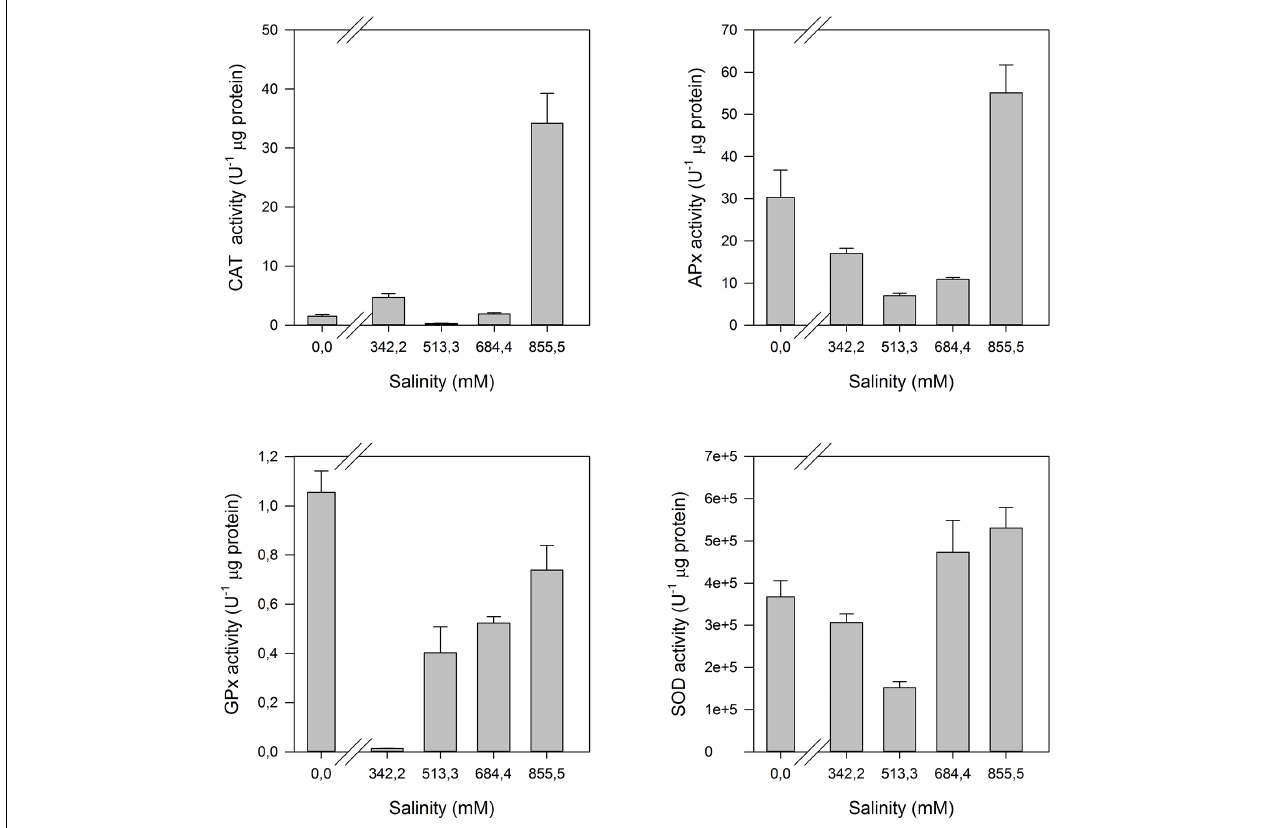
FIGURE 15 |Anti-oxidant enzymatic activities (CAT, Catalase;APx,Ascorbate Peroxidase; GPx, Guaiacol Peroxidase; SOD, Superoxide Dismutase) in the leaves of H. portulacoides exposed to a salinity gradient during 1 week (average ± SE, N =